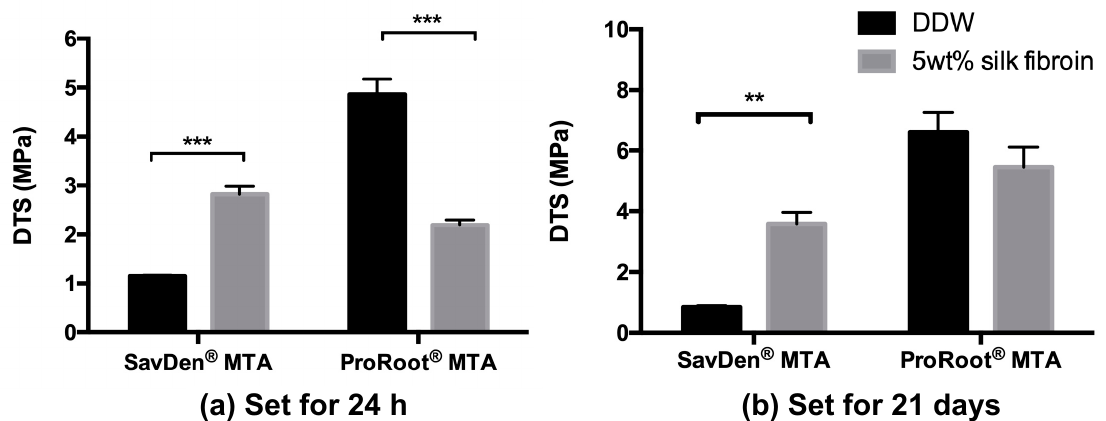
Figure 1. The diametral tensile strength (DTS) value of mineral trioxide aggregate (MTA) cements set by DDW and silk fibroin solution after ( a ) 24 h setting and ( b ) 21 days setting. ** Indicates a significant difference (P<.01). ***Indicates a significant difference (P<.001).